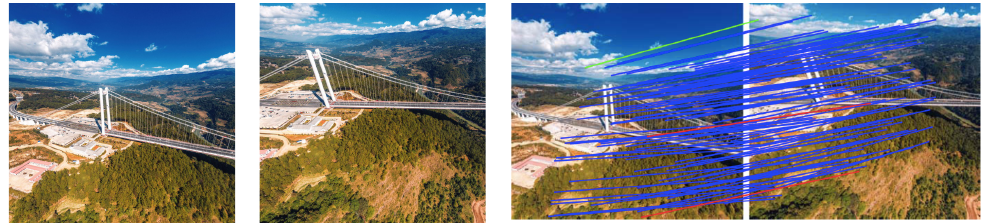
Figure 2. Pairs of pictures with parallax and matching sample